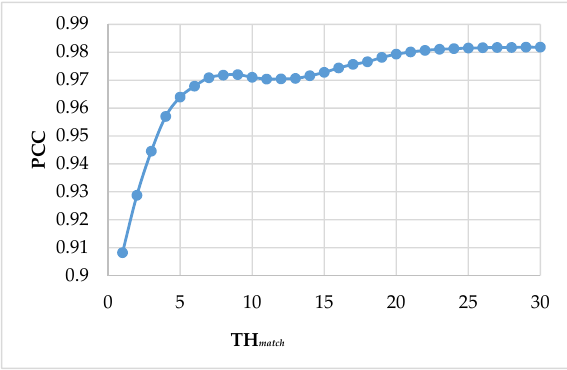
Figure 6. Percentage of correct classification ( PCC) for TH (cid:3040)(cid:3028)(cid:3047)(cid:3030)(cid:3035) ranging from 1 to 30.